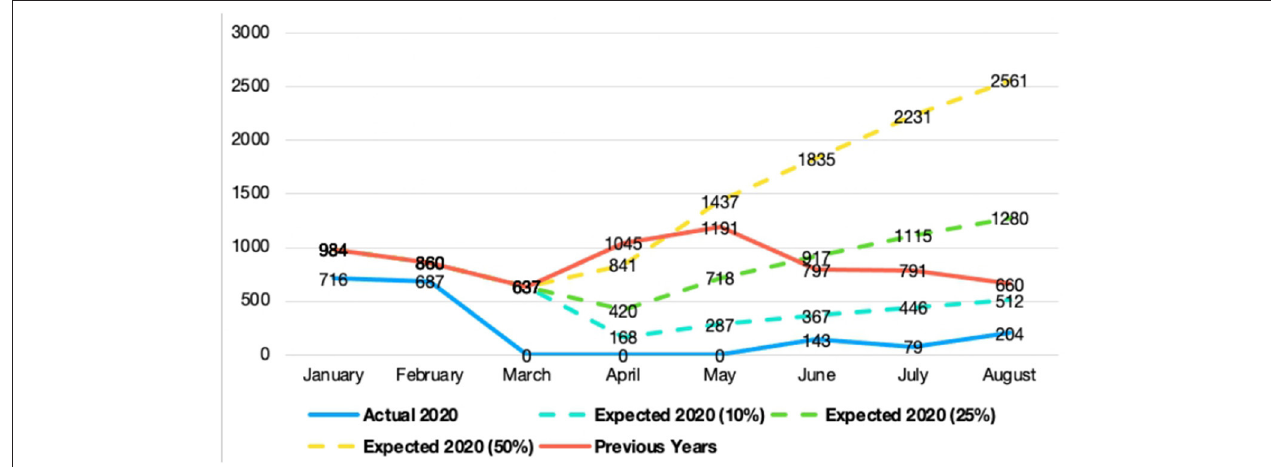
FIGURE 2 | Predicted and actual care seeking rates post the COVID Lockdown. The predicted and actual care-seeking rates as seen as outpatient numbers in the Department of Pediatric and Preventive Dentistry, JSS Dental College and Hospital, Mysuru. Previous year cases are the average values of OP numbers from the years 2017 to 2019. The predicted cases are modeled at 10, 25, and 50% using linear regression analysis. These are compared with the OP numbers of 2020 coming to a halt during the lockdown and inflow during the unlock phase post the lockdown. A statistically significant variation was observed in the number of actual and expected number of out-patients with the p-values 0.021, < 0.001, and < 0.001 for 10, 25, and 50%,